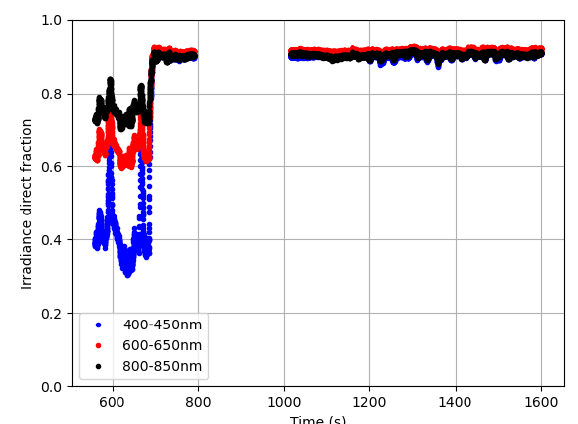
Figure 6 . Time series of the direct fraction as solved by spectral unmixing using the Köppl-method.